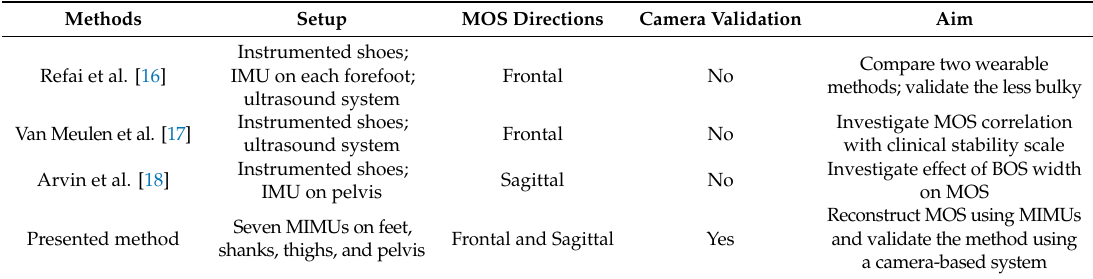
Table 1. Summary of works that performed MOS assessment using wearable systems and a comparison of their methods with the method proposed in this